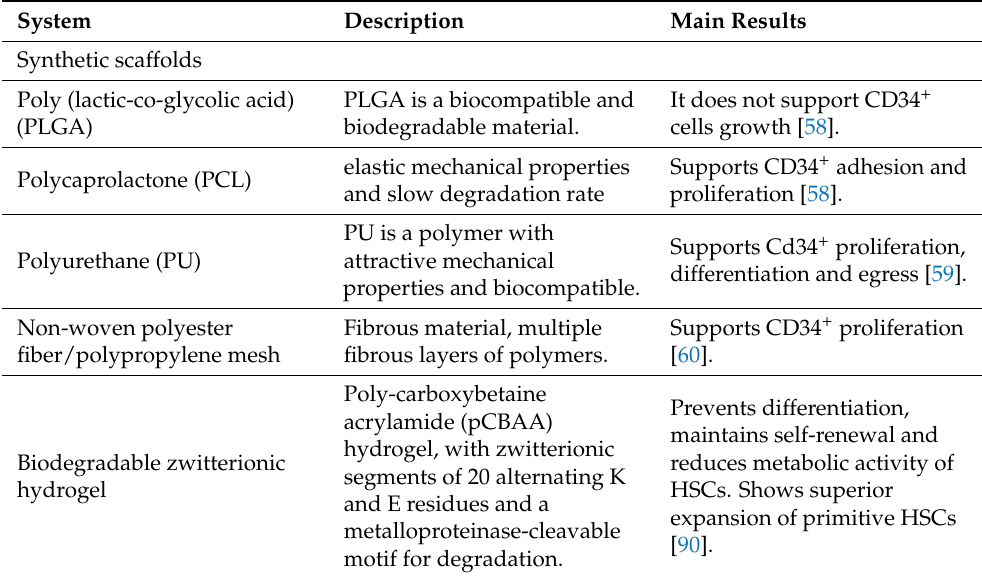
Table 1. 3D culture systems developed to mimic the bone marrow